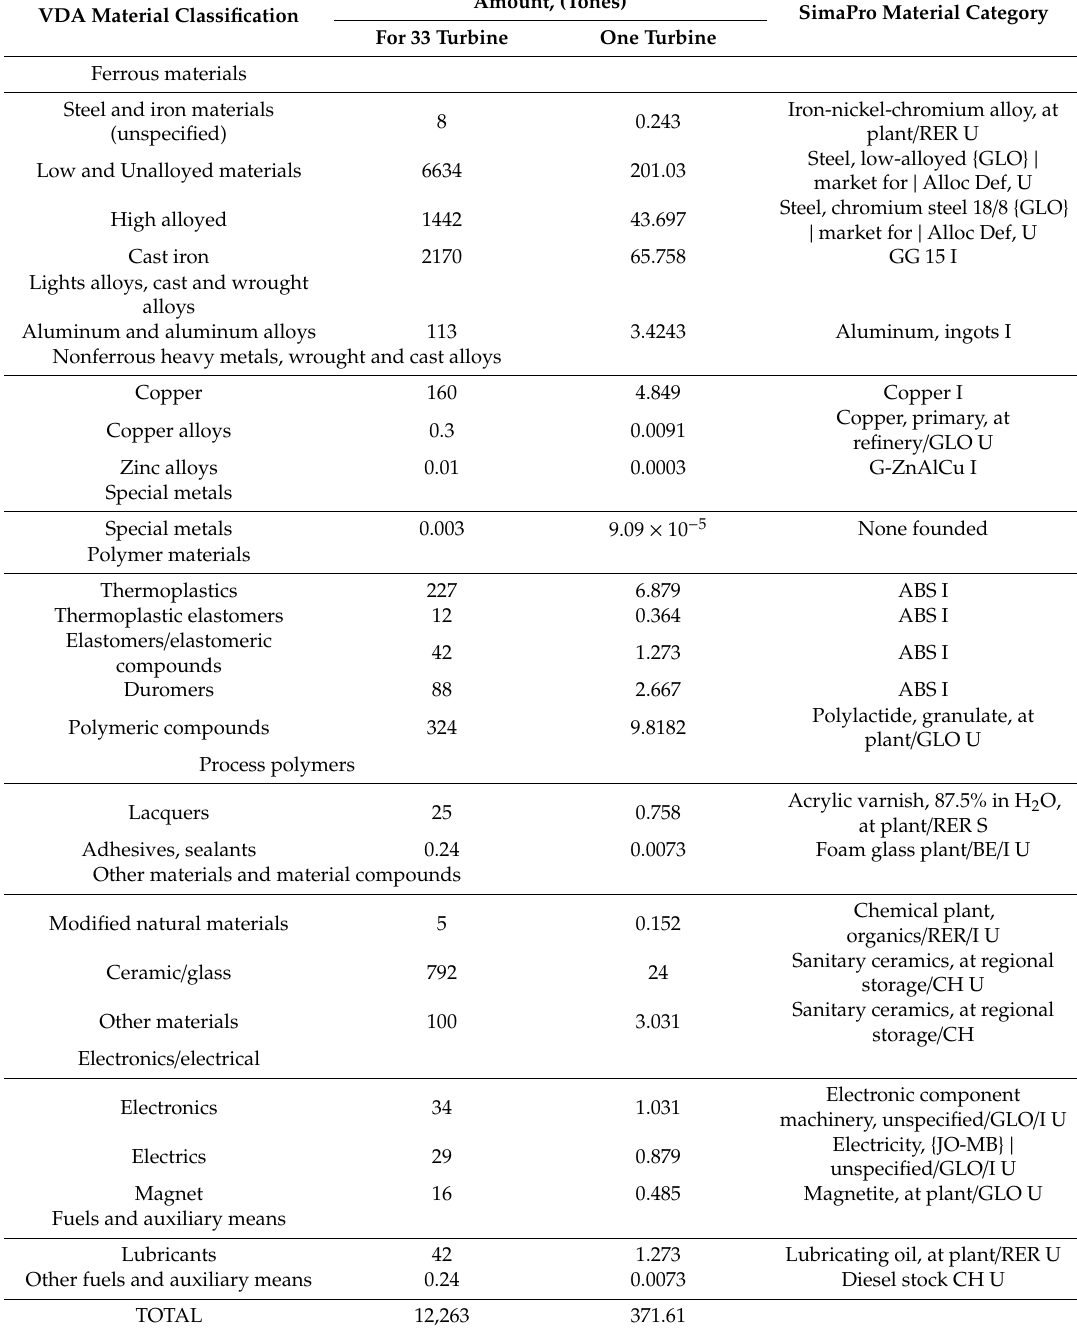
Table 1. Components of V112 Turbines.